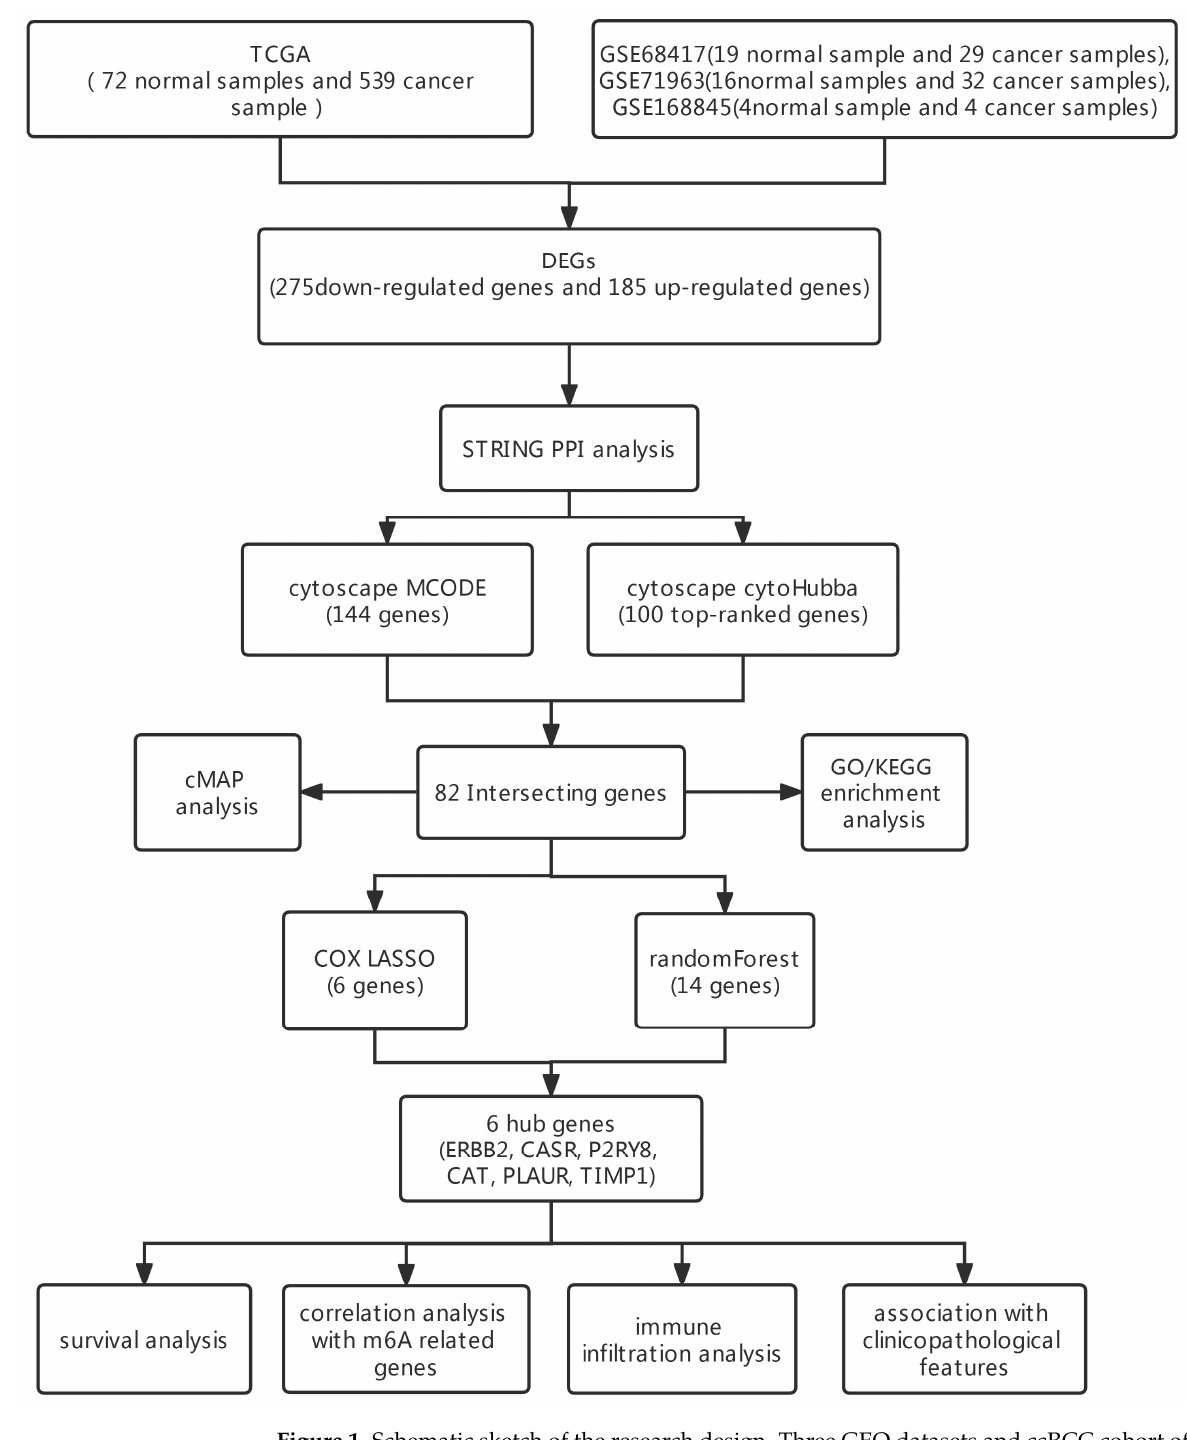
Figure 1. Schematic sketch of the research design. Three GEO datasets and ccRCC cohort of TCGA were included in present study. Through differential gene analysis, PPI, LASSO regression, and random-forest analysis, 6 hub genes were identified. Then, survival analysis, correlation analysis with m6A-related genes, immune infiltration analysis, and association with clinicopathological features were performed to understand 6 hub genes further.